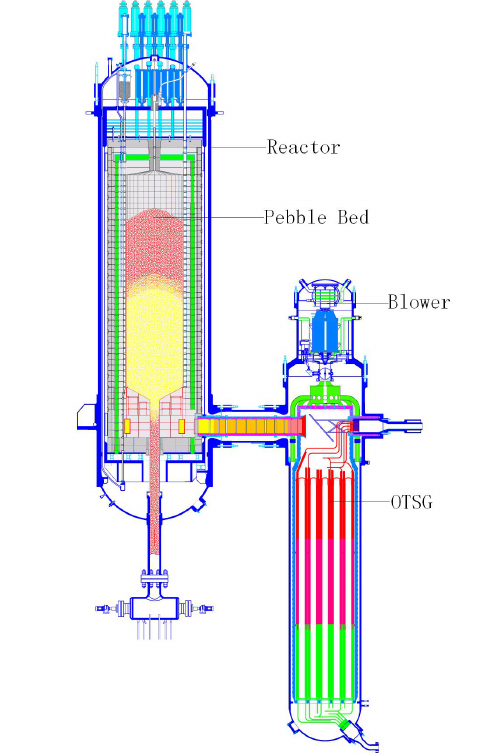
Figure 1. Schematic diagram of the HTR-PM’s